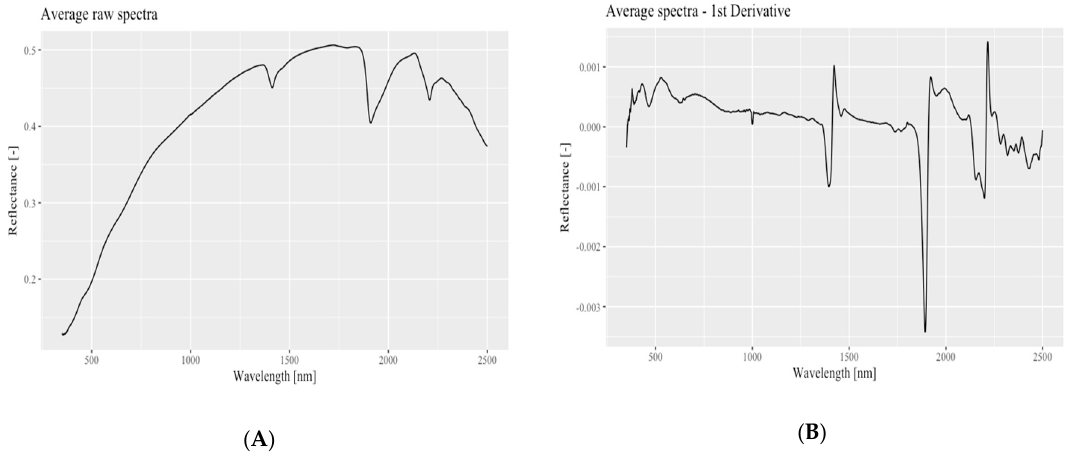
Figure 4. The spectra of soil samples derived from ( A ) raw spectra and ( B ) 1st derivative preprocessing